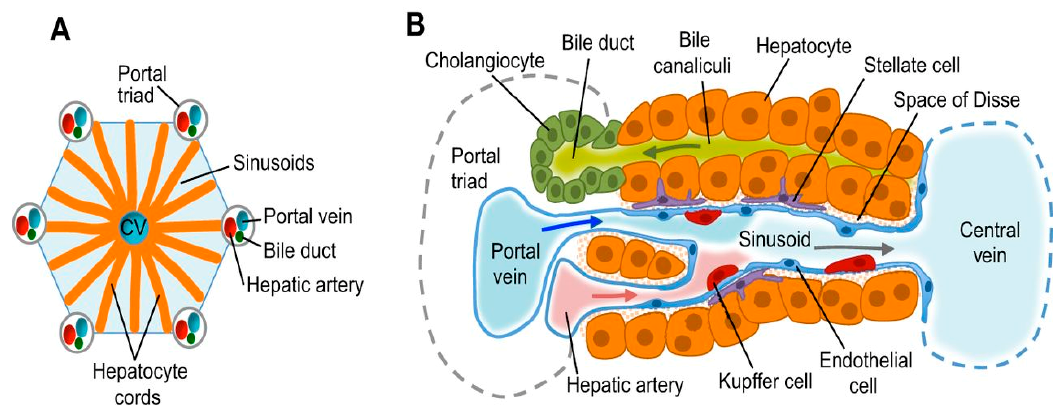
Figure 2. Liver structure and cell types ( A ) Functional unit of the liver lobules; Each lobule is composed of a central vein (CV), the portal triad consists of a portal vein, biliary duct and hepatic artery. Hepatocyte cords are separated by sinusoids that carry blood from the portal triads to the central vein. ( B ) Hepatocytes secrete bile salts into the bile canaliculi that lead to the bile duct. Stellate cells are in the space of Disse between the hepatocyte cords and sinusoids. Kupffer cells, which are the specialised macrophages of the liver, are also located in sinusoids. Epithelial cells lining the bile ducts are called Cholangiocytes (Adapted from Gordillo et al. [6]).